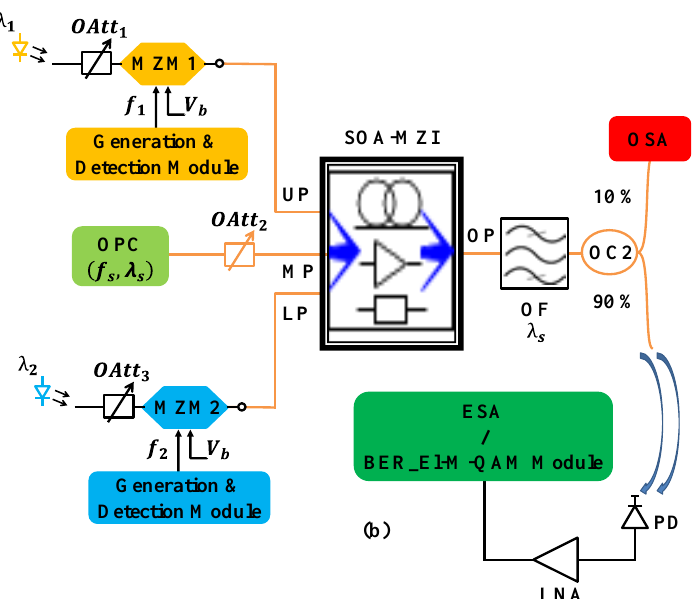
Figure 5. Block diagram of the simulation setup of QPSK frequency mixing for co-direction configuration. OAtt: Optical Attenuator, OF: Optical Filter, LNA: Low-Noise Amplifier, MZM: Mach–Zehnder Modulator, OC: Optical Coupler, BER: Bit Error Rate, QAM: Quadrature Amplitude Modulation, PD: Photodiode, and 𝑉 𝑏 : Bias voltage. ( a ) Standard modulation mode, ( b ) Differential modulation mode.